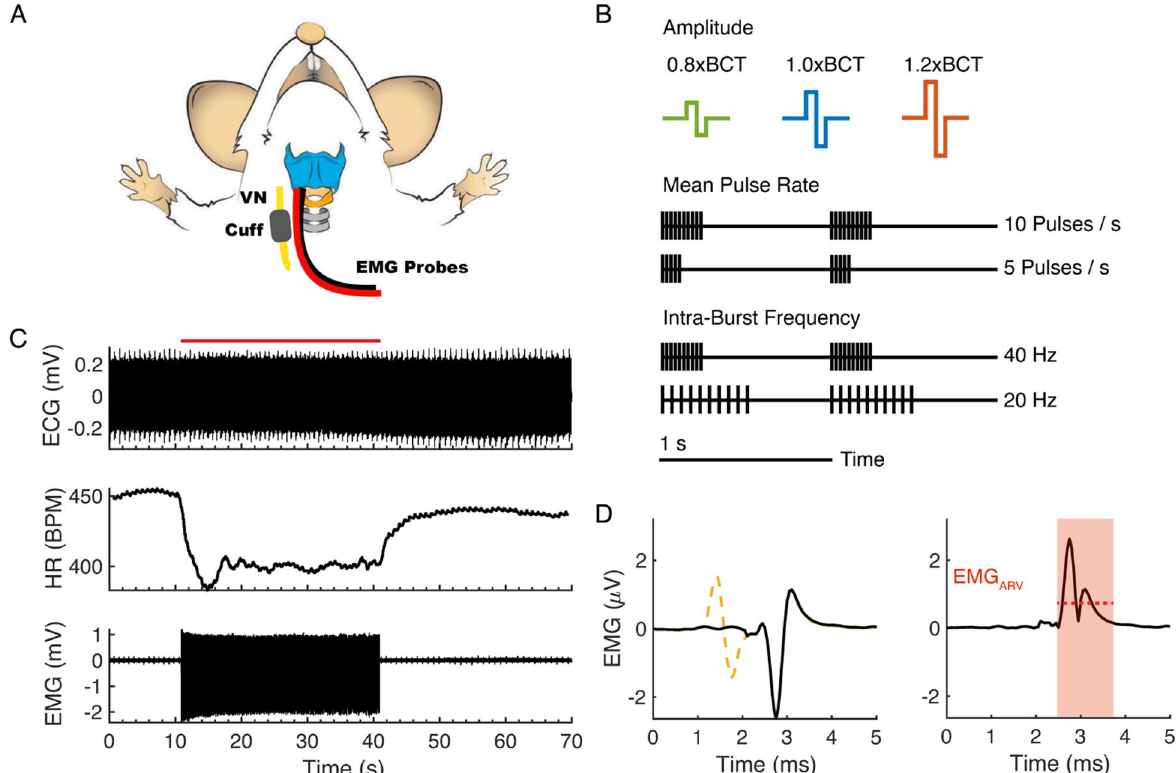
Fig. 1 In vivo data acquisition, stimulation parameter design, and outcomes quantification. A Schema of vagus nerve stimulation (VNS) showing cuff implantation site on the right cervical vagus nerve and two wire electrodes placed under the thyroid cartilage to measure EMG